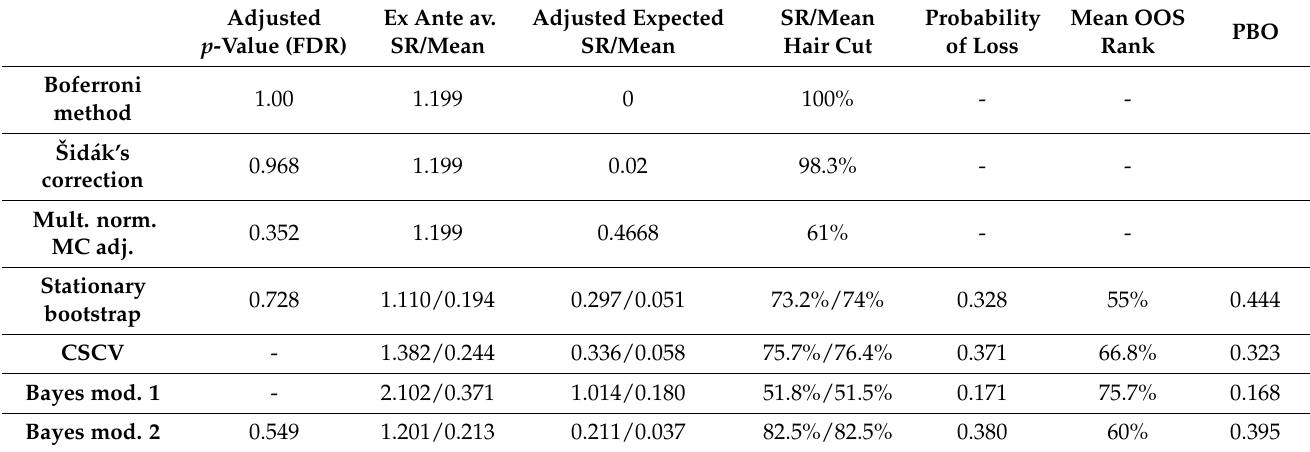
Figure 9. Stationary bootstrap simulation histogram of the OOS relative rank of the best IS strat- egy.